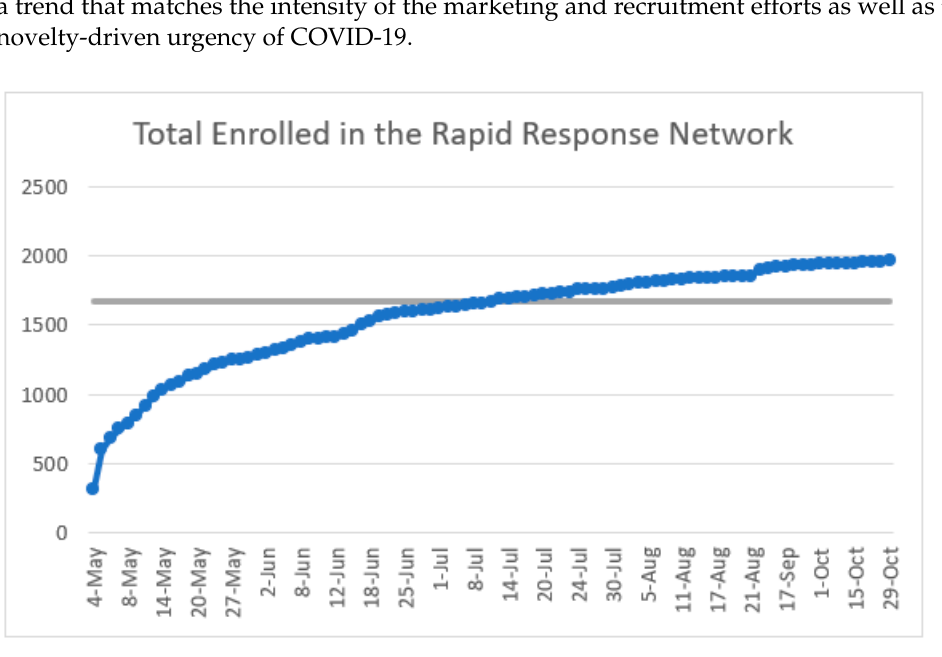
Figure 2. Total participant enrollment in the RRN (May–October 2020).